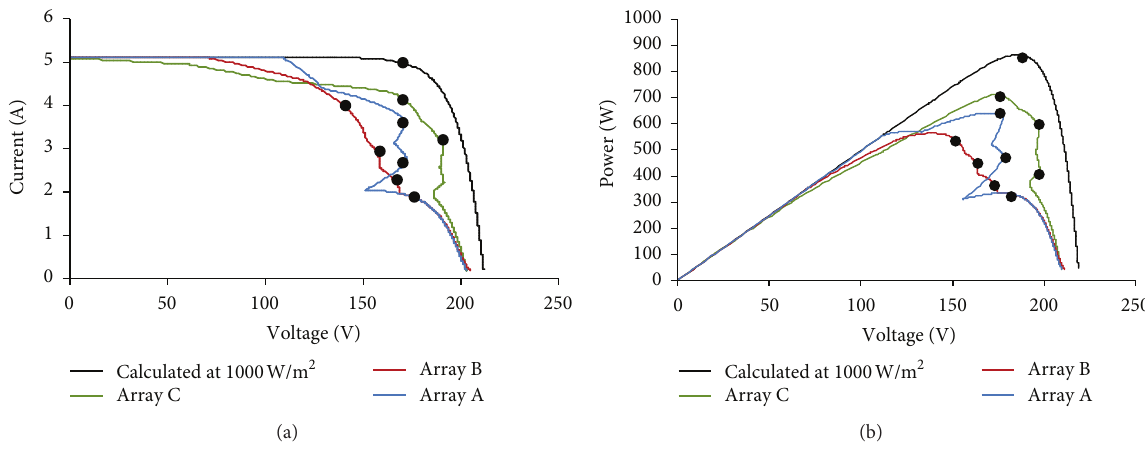
Figure 8: (a) 𝐼𝑉 characteristic curves, (b) 𝑃𝑉 characteristic curves of PV array at 1000W/m 2 and mismatch irradiance